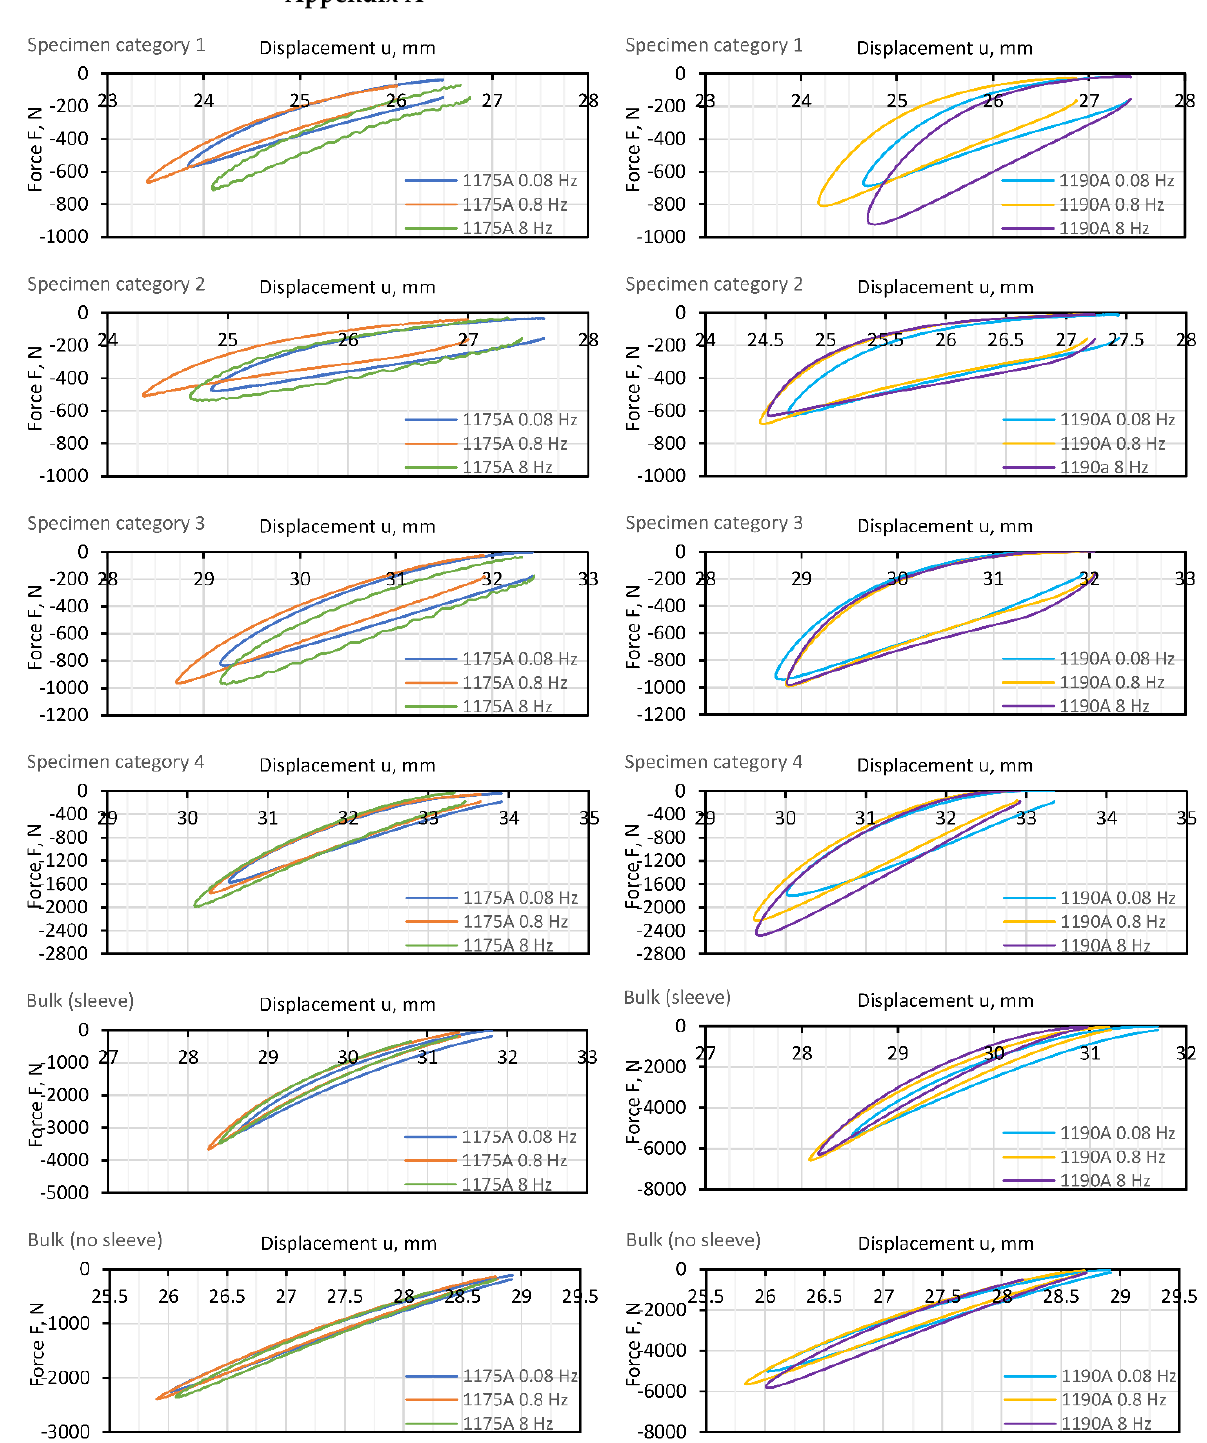
Figure A1. Force–displacement curves after the first load cycle as recorded for all Specimen categories at all three frequencies.